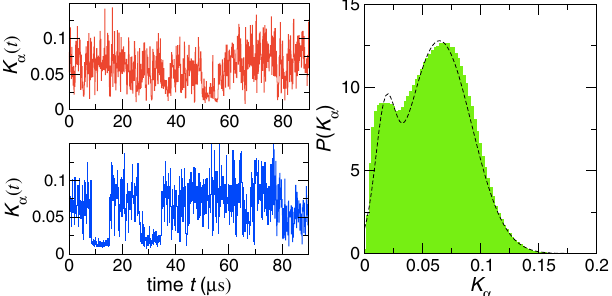
FIG. 9. (Left) Temporal fluctuation of the diffusivity K α ð t Þ for two chosen individual lipid molecules in the protein-crowded DPPC membrane. The diffusivity K α is given in units of μ m 2 = ns α and the temporal resolution is 100 ns. (Right) Probability density P ð K K α Þ for the obtained α value from all DPPC lipid molecules in the protein-crowded membrane. The dashed line represents a double-Gaussian fit to the data. Plots corresponding to the protein-poor system and nonaggregating systems can be found in Figs. S11 and S10 in Supplemental Material